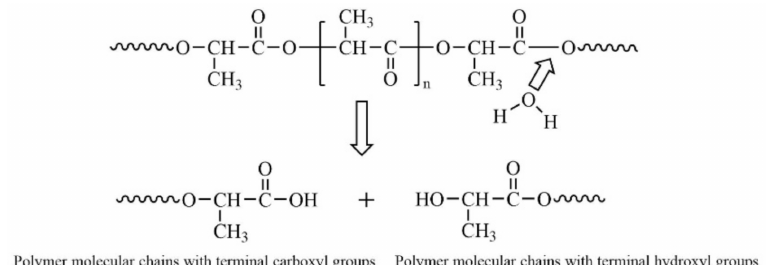
Figure 4. Hydrolysis mechanism of PLA. Reprinted from Ref. [175]. Copyright (2016), with permis- sion from Springer.